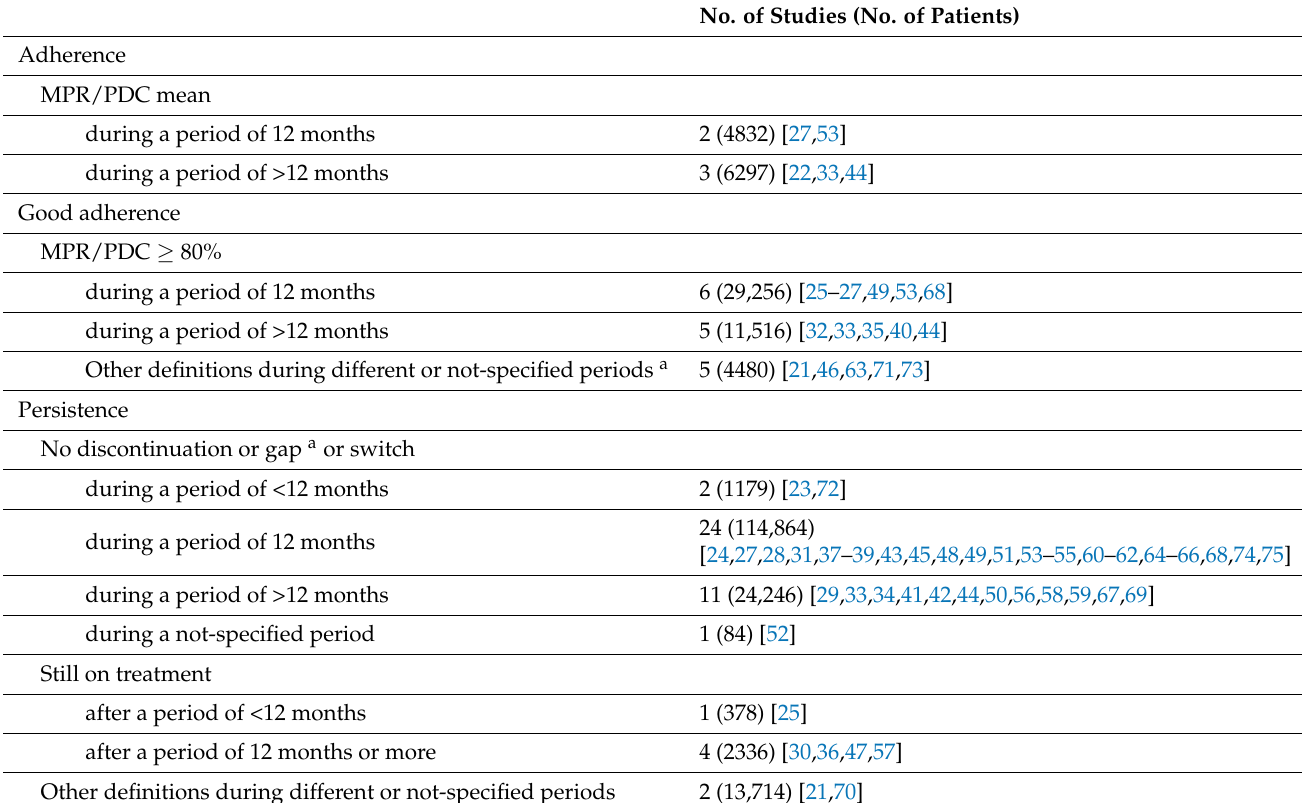
Table 1. Details of calculation methods in considered outcomes. No. of Studies (No. of